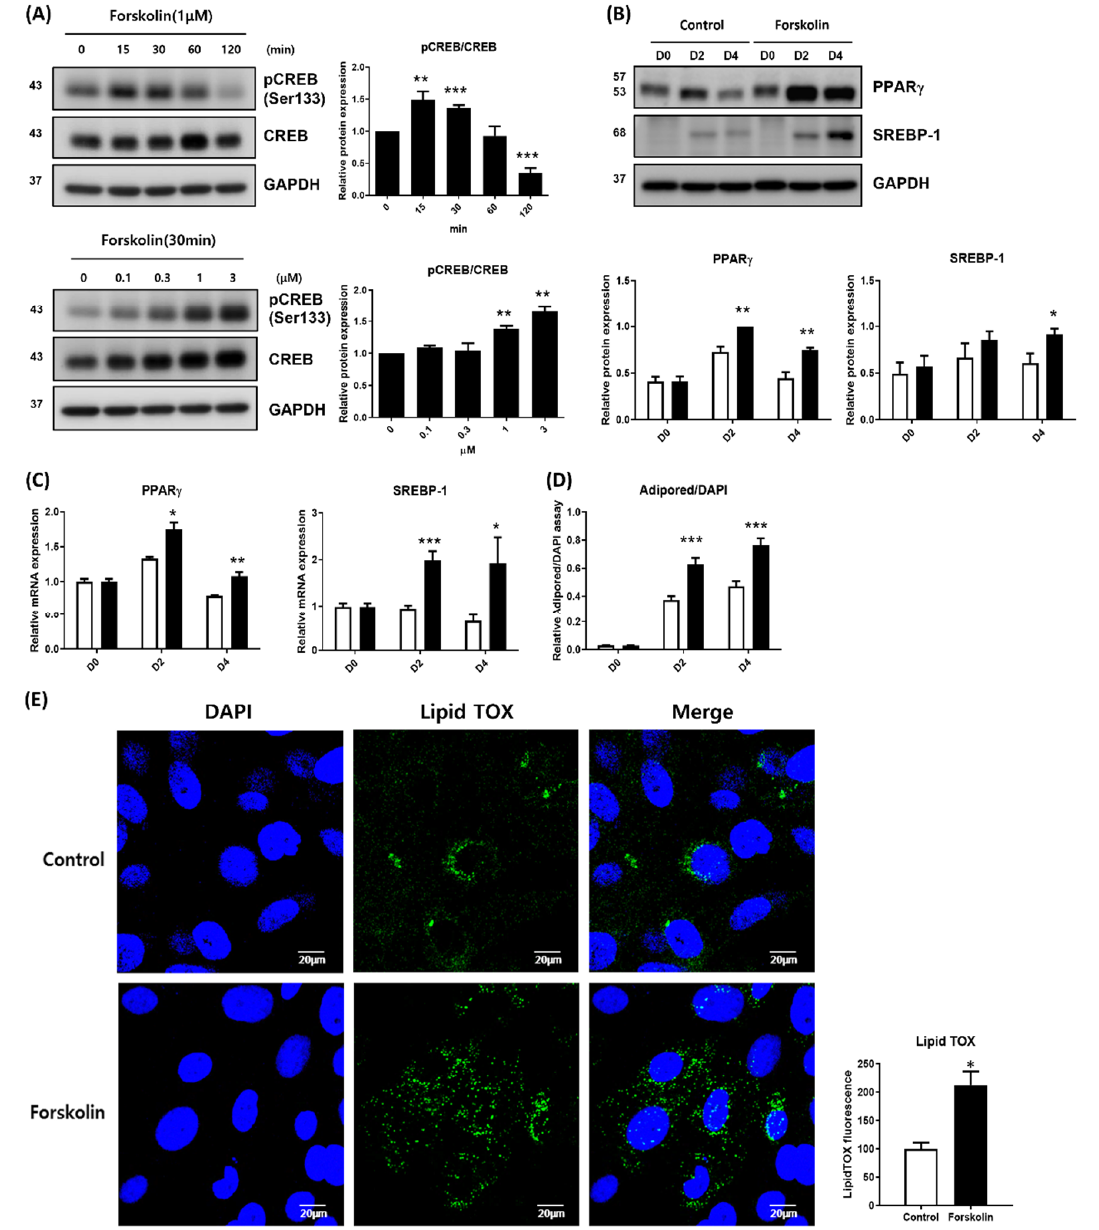
Figure 1. PKA activation enhanced lipid synthesis in human meibomian gland epithelial cells (HMGECs). ( A ) HMGECs were treated with forskolin, and the phosphorylation of CREB at ser133 residue was assessed by immunoblotting in serial and dose escalation manners. After treatment with forskolin (1 μ M), the CREB phosphorylation was assessed with time. CREB phosphorylation was highest at 30 min after treatment and decreased thereafter. After forskolin was treated by concentration, CREB phosphorylation was observed 30 min later. CREB phosphorylation increased with forskolin concentration (the sum of 3 and 4 experiments, respectively). ( B – D ) HMGECs were cultured with or without forskolin (1 μ M; forskolin was treated at day 0 and 2). ( B , C ) mRNA and protein expression of PPAR γ and SREBP-1 were assessed by quantitative PCR and immunoblotting at day 0, 2, and 4 (the sum of 3 and 4 experiments respectively). ( D , E ) Lipid accumulation was measured by AdipoRed assay and LipidTOX assay at day 4, and the results of three experiments are summarized. Data are presented as the mean ± standard error of the mean. D, day after differentiation; * p < 0.05; ** p < 0.01; *** p < 0.001.